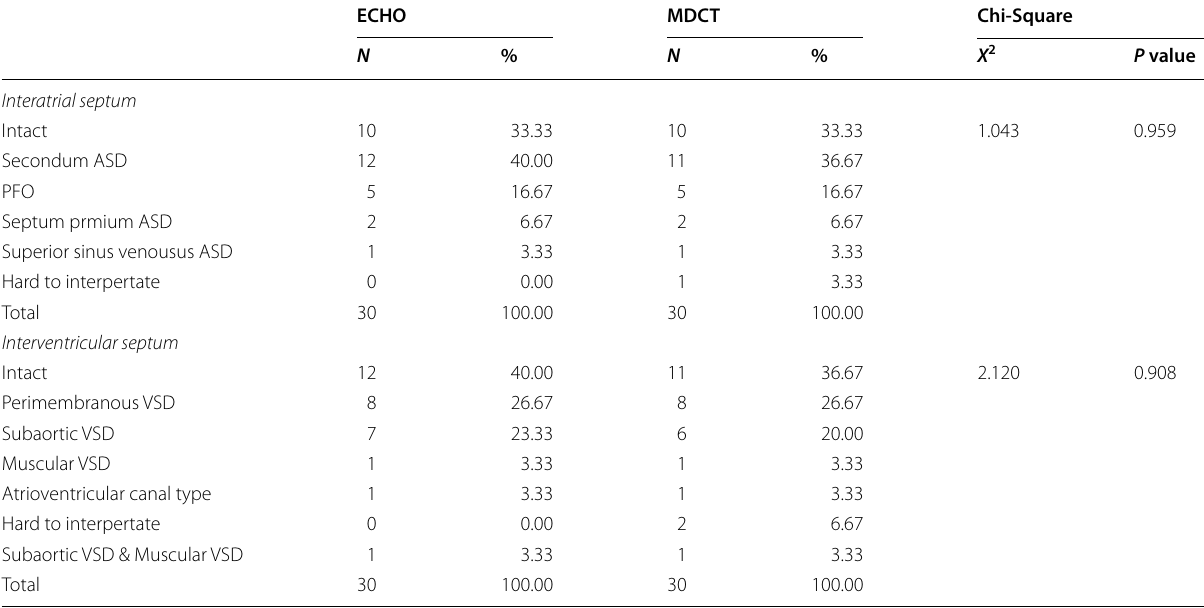
Table 4 Interatrial septum and interventricular septum defects detected by Echocardiography and MDCT angiography ECHO MDCT